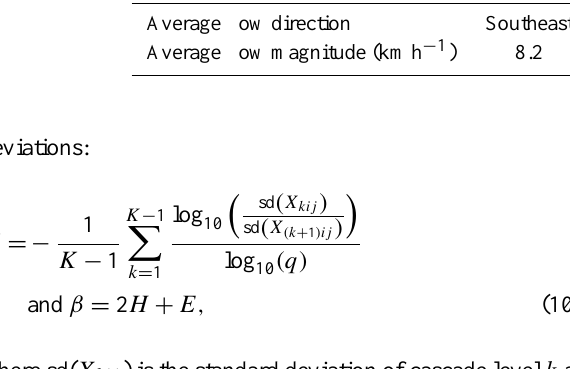
Table 1. Characteristics of the six flow cluster centers that are used to stratify the statistics. Wm and Ws refer to moderate and strong westerly flows respectively. The detailed average velocity maps can be found in Foresti and Seed (2014). Cluster